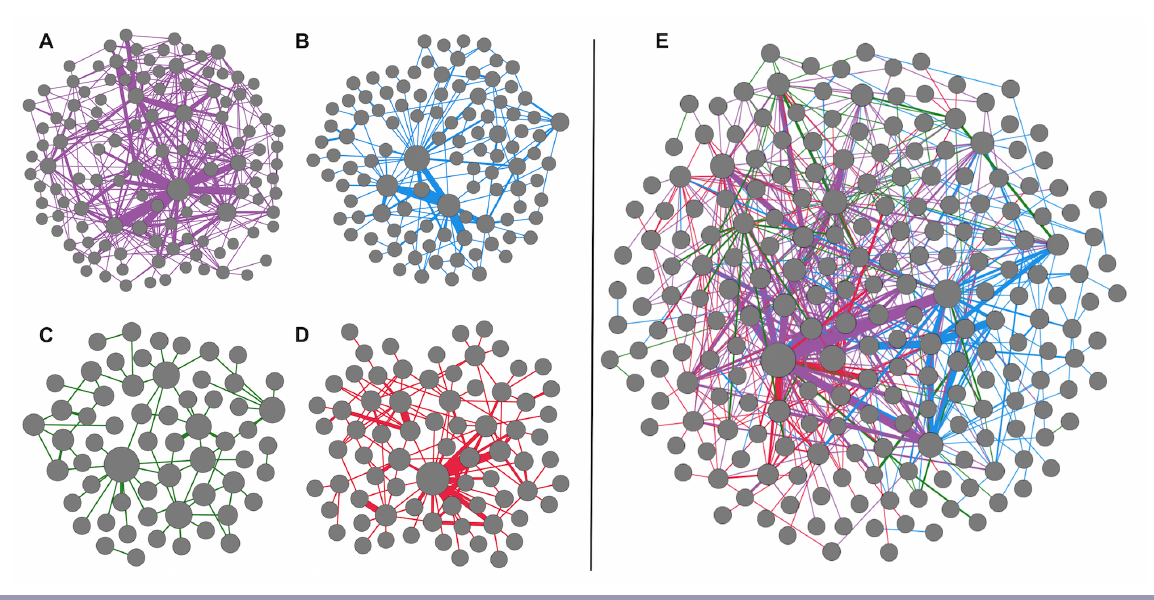
Fig. 1 . Multigraph networks representing diverse types of relationships identified by fishermen (purple = species abundance or distribution; blue = species behavior; green = system health; red = food web). (A–D) Composite networks for each of the four primary types of local ecological knowledge described by all fishermen. Edges and nodes weighted by the number of interviewees that described each relationship. (E) Composite network for all types of ecological knowledge described by all fishermen.